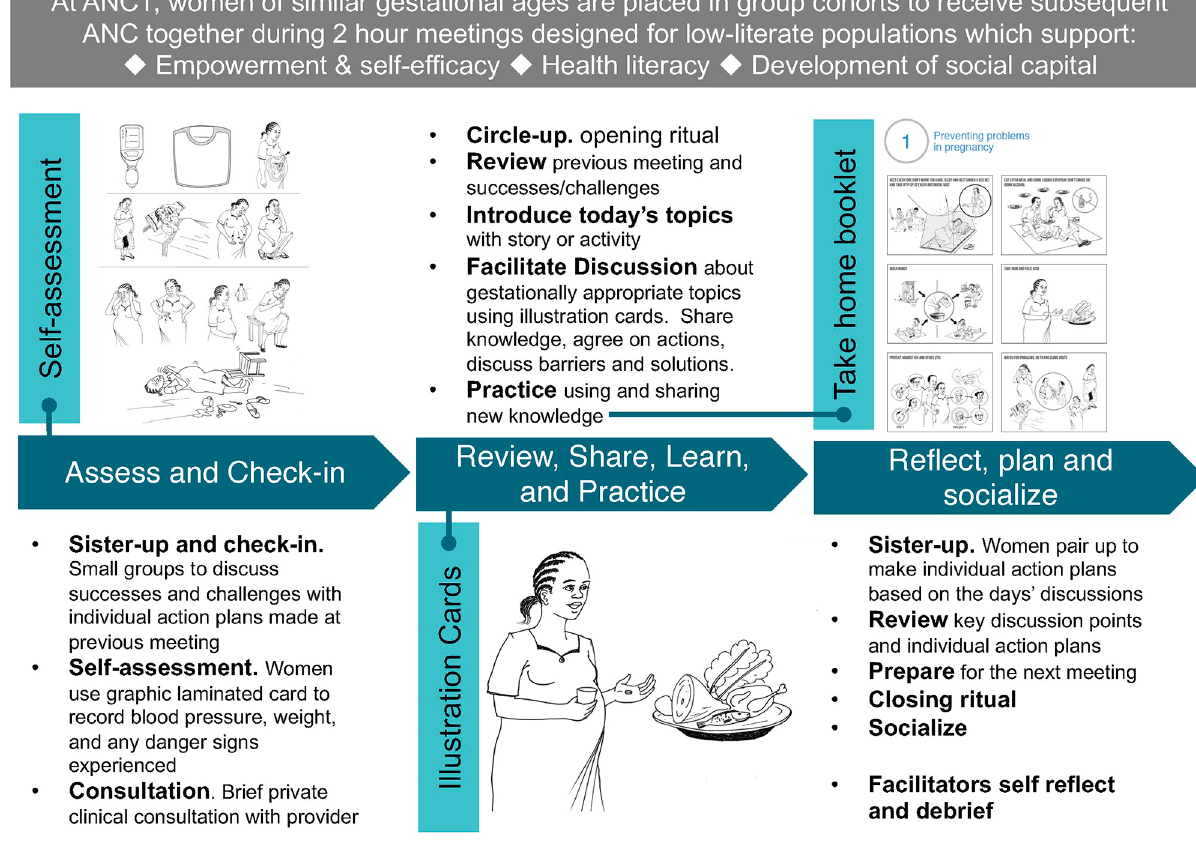
Fig 1. Group antenatal care (G-ANC) meeting framework. Images republished from Jhpiego’s 2016 five-meeting Group Antenatal Care package under a CC BY license, with permission from Jhpiego corporation, original copyright 2016.